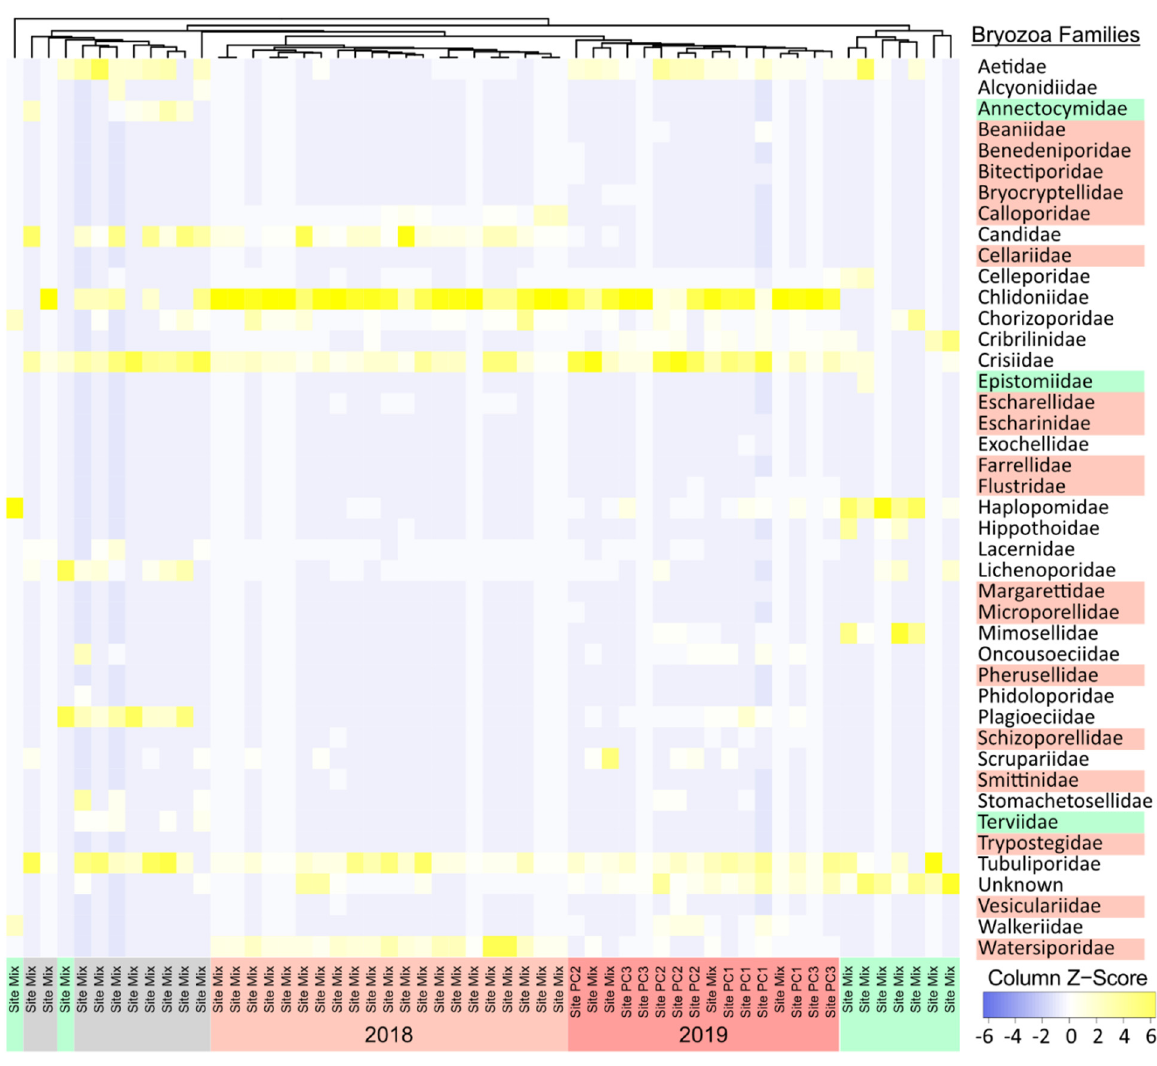
Figure 5. Visualization of Spearman ranked correlation of the abundances (colonies per m² seafloor) of bryozoan families. Samples of Posidonia oceanica leaves and shoots are indicated in green and grey, respectively. Phyllophora crispa samples are indicated in light red (2018) and dark red (2019). Bryozoa families highlighted in green were exclusive to Posidonia oceanica , highlighted in red were exclusive to Phyllophora crispa .